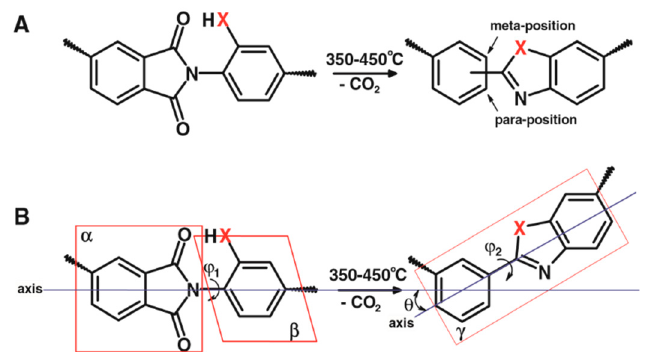
Figure 9. ( A ) Changes in conformation–polymer chains consisting of meta- and/or para-linked chain conformations can be created via rearrangement. ( B ) Spatial relocation due to chain rearrangement in confinement, which may lead to the generation of free-volume elements [62].